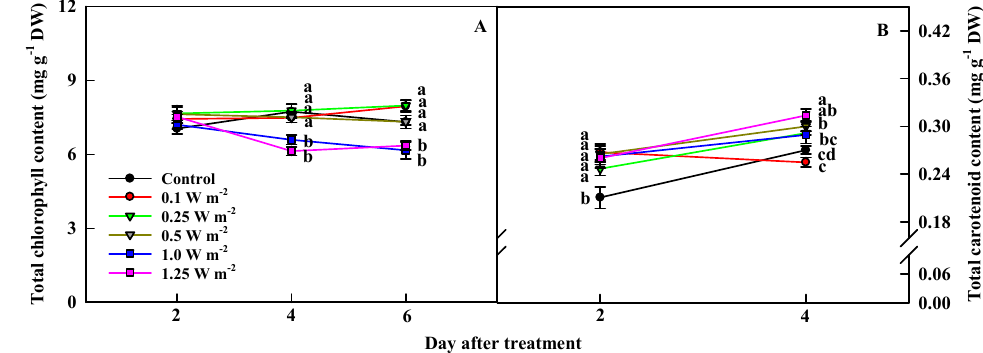
Figure 4. Total chlorophyll ( A ) and total carotenoid ( B ) contents of C. denticulatum subjected to five energy levels of UV-B radiation for 6 days. The UV-B treatments started after 5 weeks of transplanting. Different letters next to bars indicate a significant difference by Duncan’s multiple range test at p < 0.01 ( n = 12).